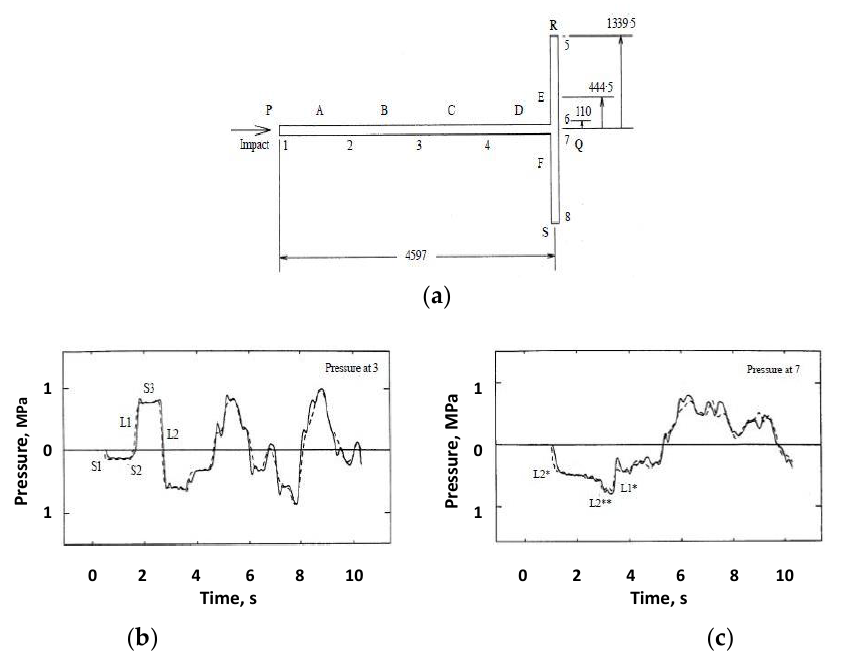
Figure 6. Influence of axial and flexural stresses in pipe walls (after Vardy et al. [15]). ( a ) T-piece experiment. ( b ) Axial pipe only. ( c ) Full T-piece configuration.